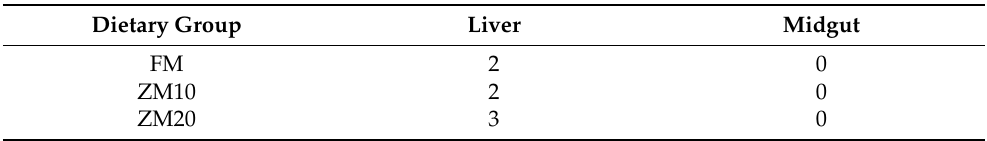
Table 6. Severity score (expressed as Grade 0–4) for the observed histopathological alterations. Sever- ity grading used the following system: Grade 0 (not remarkable), Grade 1 (minimal), Grade 2 (mild), Grade 3 (moderate), and Grade 4